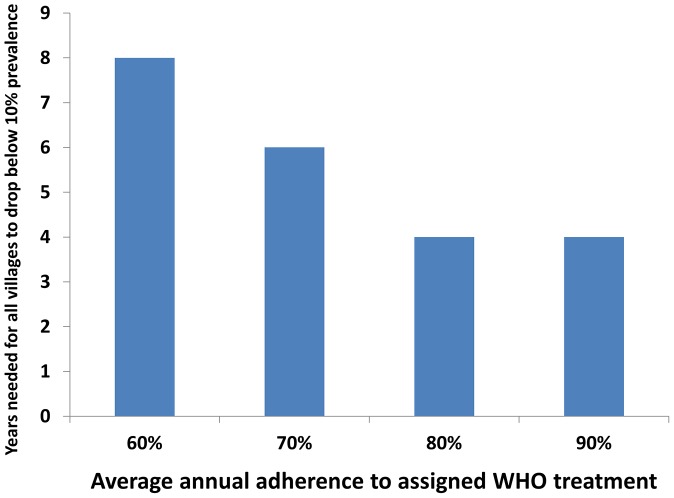
Modeling time-to-success for current WHO treatment strategies, as a function of program adherence.In this SWB model simulation for the 10 interlinked villages in Figure 1, WHO treatment assignment was made based on current recommendations for high- and moderate-prevalence communities (see Table 2). The bars indicate the number of years required for the overall area school-age population prevalence to drop below 10% (y-axis). This working target is a prevalence level is felt to be associated with minimal risk of advanced schistosomiasis [16]. As shown in the different bars along the x-axis, the time to needed to achieve the <10% global prevalence target varied according to the population participation (adherence) with the implemented treatment program. At 80–90% adherence among children (achieved in many research control programs), it took a minimum of 4 years of treatment (as assigned in year 1, based on starting prevalence) to achieve the <10% target. Where adherence was less good (60–70%, typical of many non-research national programs), control was projected to take appreciably longer (6–8 years on the assigned treatment strategy).